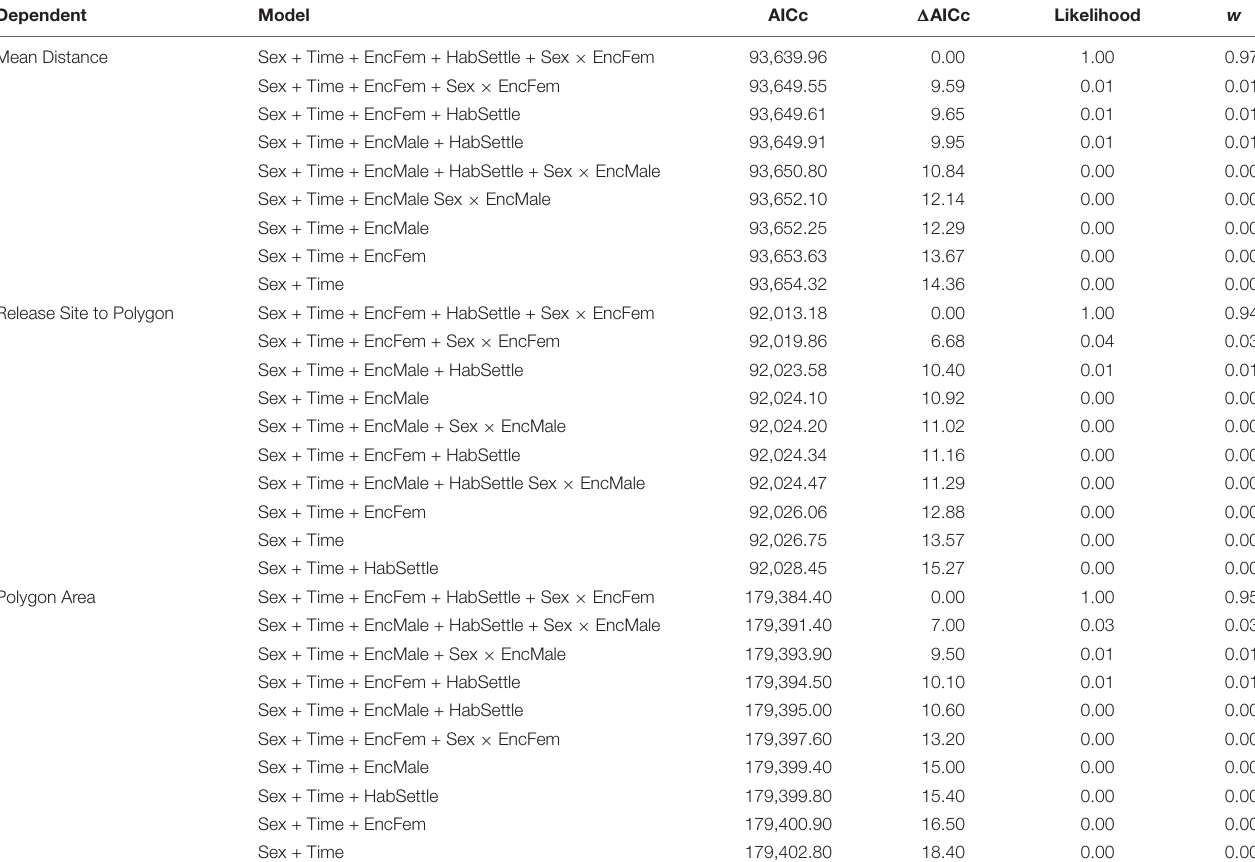
TABLE 3 | Model selection criteria including the AIC c scores, (cid:49) AICc comparing top model to other competing models, the likelihood of each model, and the model weight ( w ) for each of six competing model from analyses of three dependent metrics of fisher movements after reintroduction. Dependent Model AICc (cid:49) AICc Likelihood Mean Distance